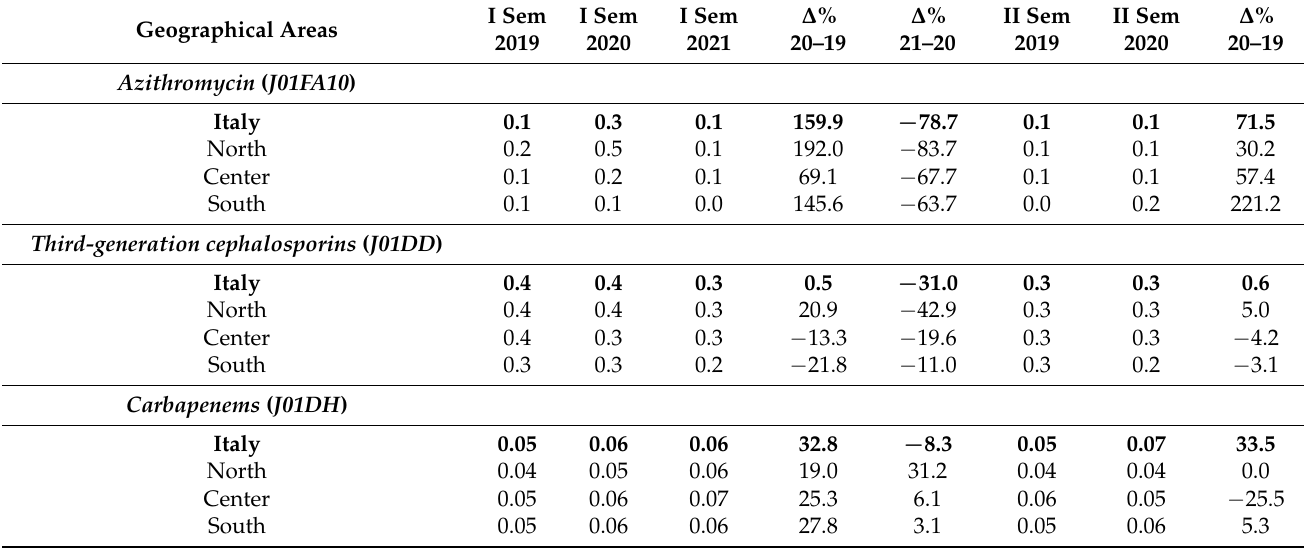
Table 3. Consumption (DDD/1000 inhabitants per day) of azithromycin, third-generation cephalosporins, and carbapenems in the hospital setting: comparison 2019–2021.